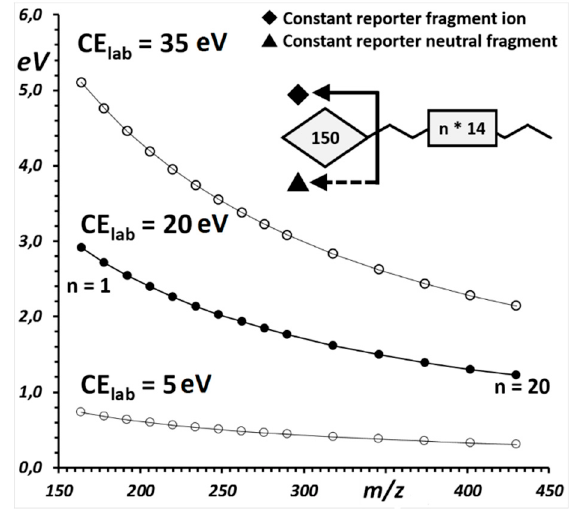
Figure 1. Center-of-mass collision energy calculated for precursor ions of different m / z and for different values of laboratory-frame collision energy (5, 20 and 35 eV). The m / z values of the precursor ions are calculated for a homologous series of metabolites constituted by a common motif of a molecular mass of 150 Da (that which gives rise to the diagnostic precursor-to-fragment transition) and of a homologous 20-methylene series. Center-of-mass collision energy is calculated according to Equation (1), with Nitrogen as the collision gas (see Section 2.1).